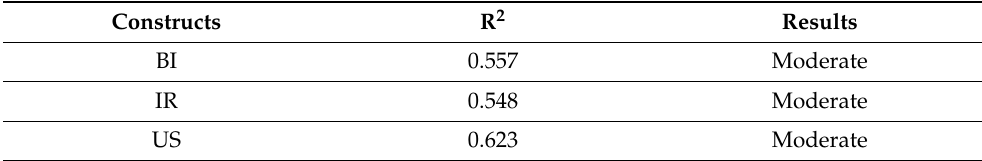
Table 9. R 2 of the endogenous latent variables.